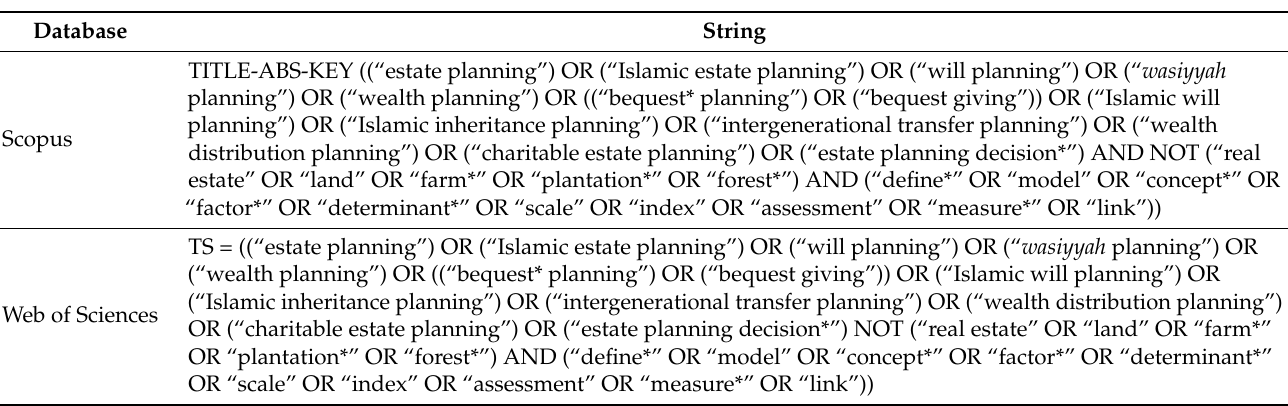
Table 1. Search string used in the selected databases.